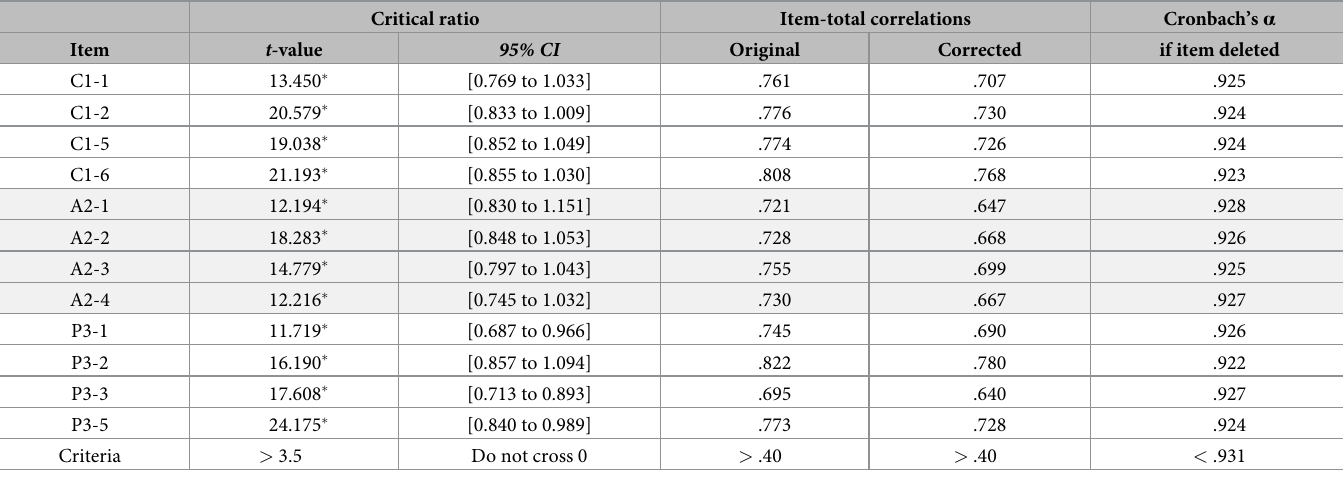
Table 3. Results of item analysis of 12 questions in the entire L-SES.